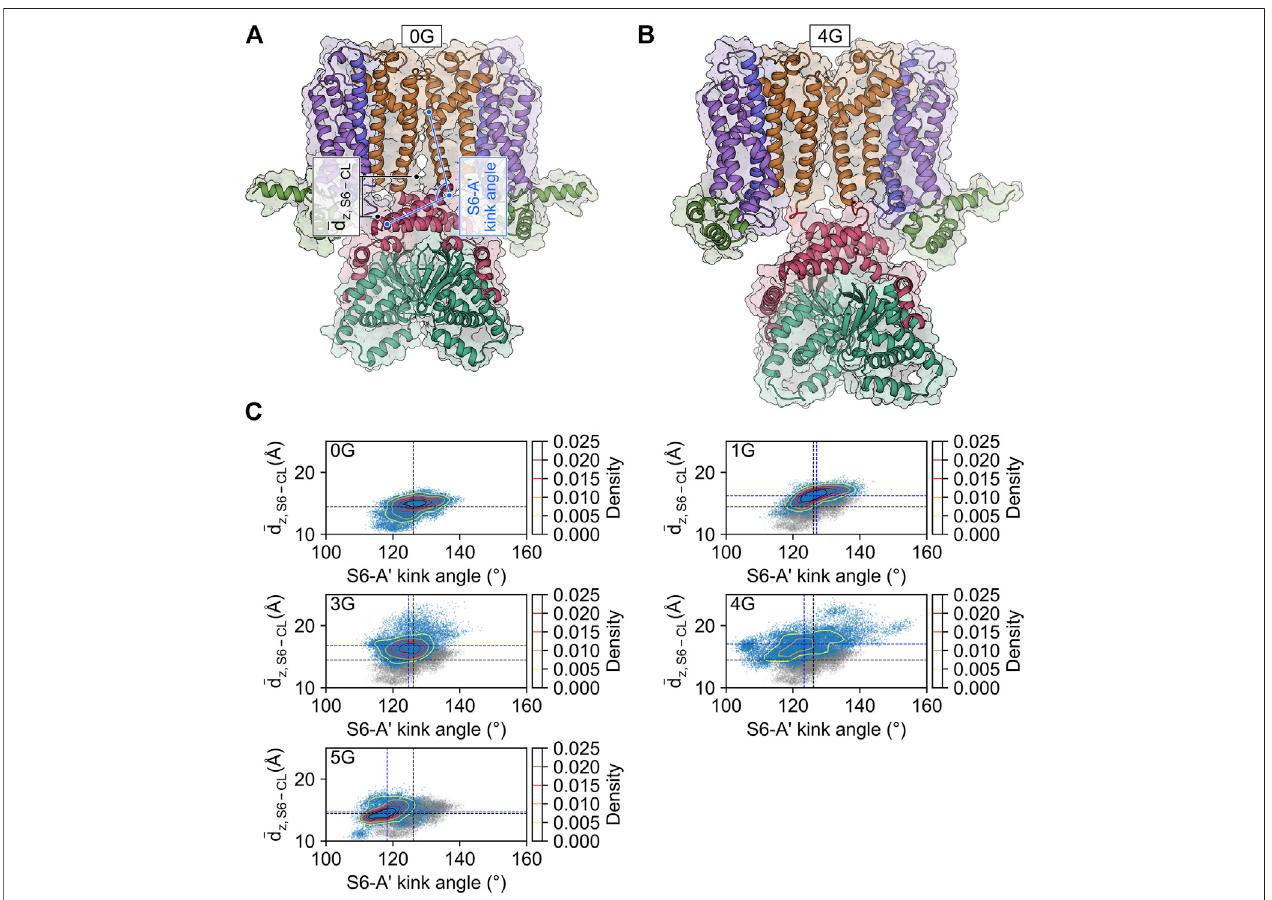
FIGURE4| CL-CNBDdisplacementinglycinelinker-carryingconstructs. (A) StartingstructurefortheMDsimulation oftheHCN2 wildtypechannel(0G).Thecolor scheme corresponds to the one in Figure 1A . The geometric parameters used to characterize the conformational changes are the vertical distance between the C-terminus of the S6-helix and the C-linker of the counter-clockwise preceding subunit as viewed from the extracellular side ( d z, S6 – CL , black), and the S6-A ′ kink angle (light blue). (B) Snapshot of the fi nal state of the second simulation of 4G. The color scheme is identical to that in panel A, with the glycine linkers colored in red. Compared to the wild type, 4G displays a pronounced downward displacement of the CL-CNBD. (C) Scatter and contour plots of the two geometric parameters in the MD simulationsof0G, 1G,3G, 4G,and 5G. Values oftheaverage structure ofHCN2 are indicated withdashed blacklinesand thoseoftheconstructswithdashed blue lines. In the plots for the glycine linker constructs, the scatter plot for HCN2 is shown in gray for comparison.